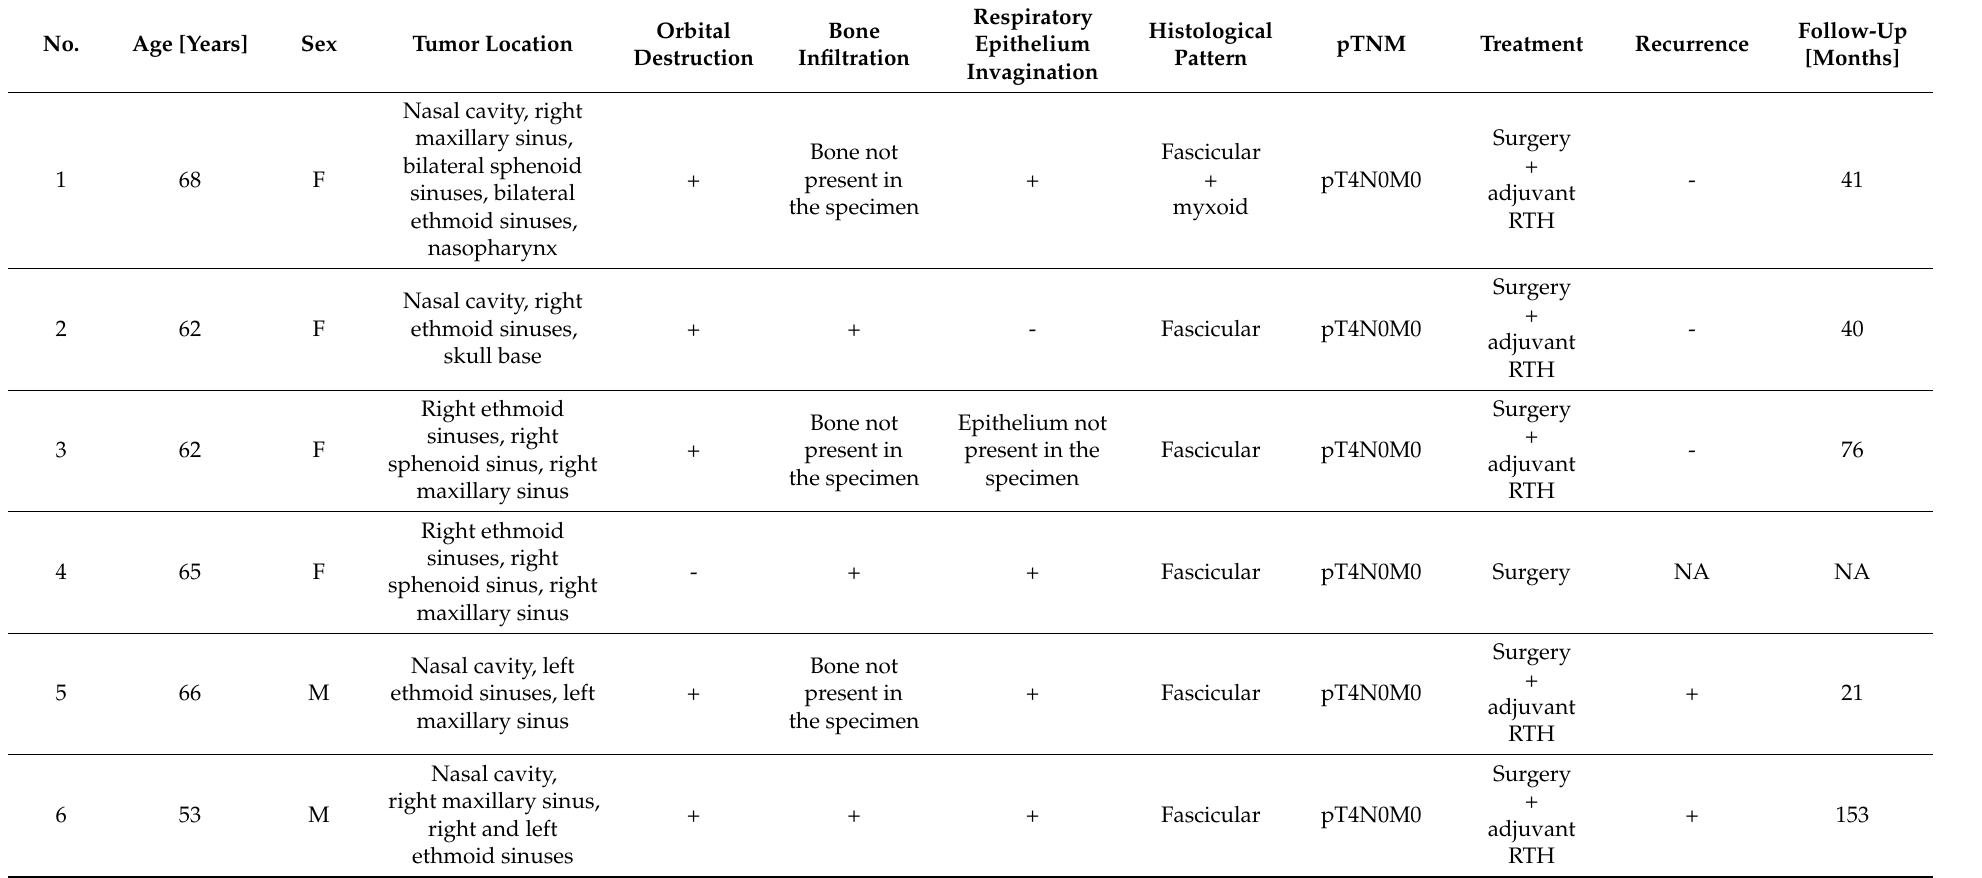
Table 2. Clinicopathological characteristics of patients with